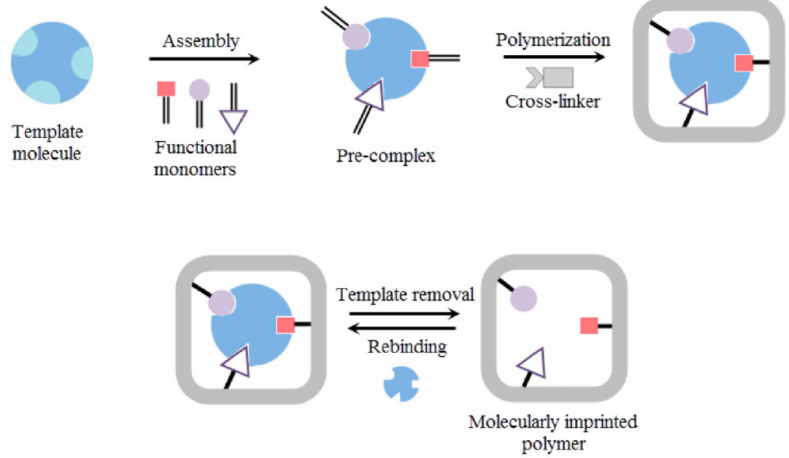
Figure 38. Molecular Imprinting polymers synthesis protocol (reproduced from [176] with permission from Sensors , MDPI licensed under Creative Commons Attribution (CC BY 4.0)